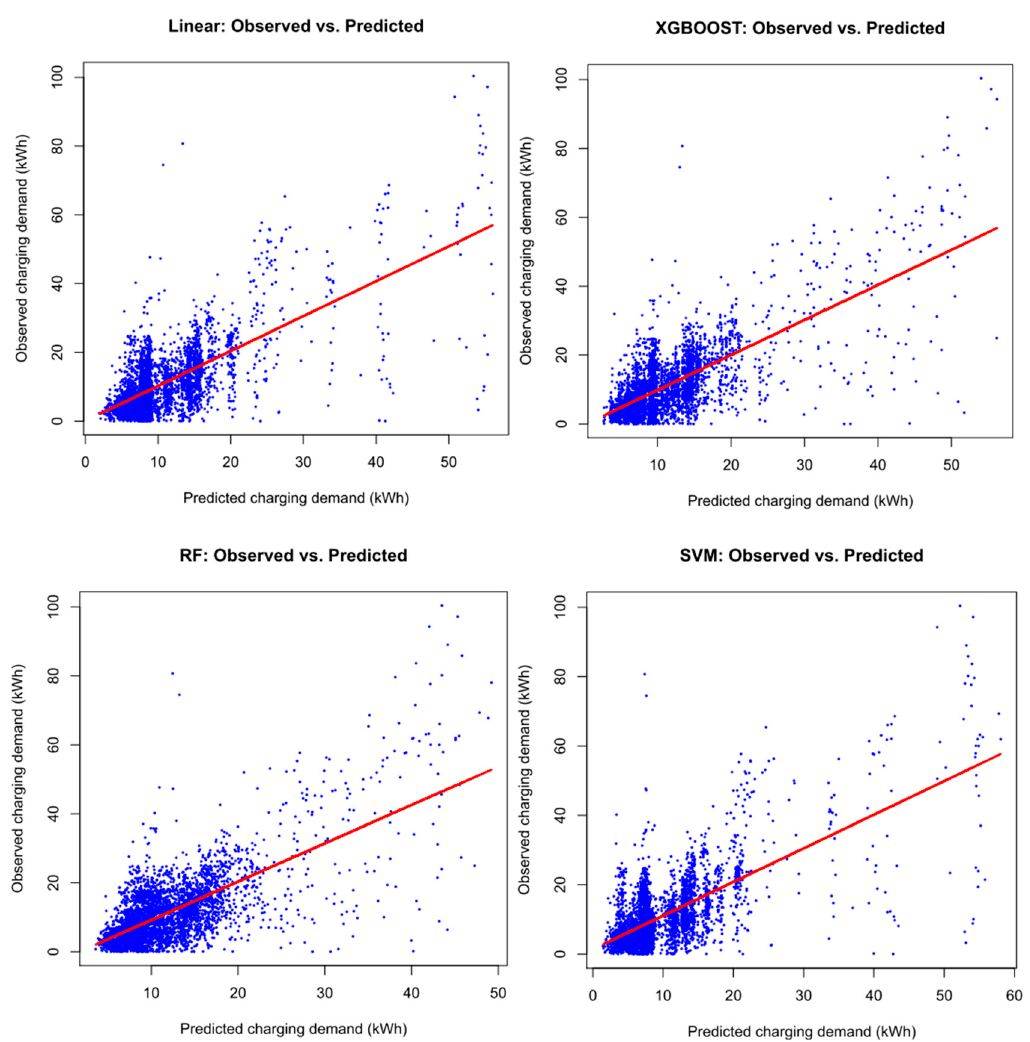
Figure 7. Predicted vs. Observed values for each method.